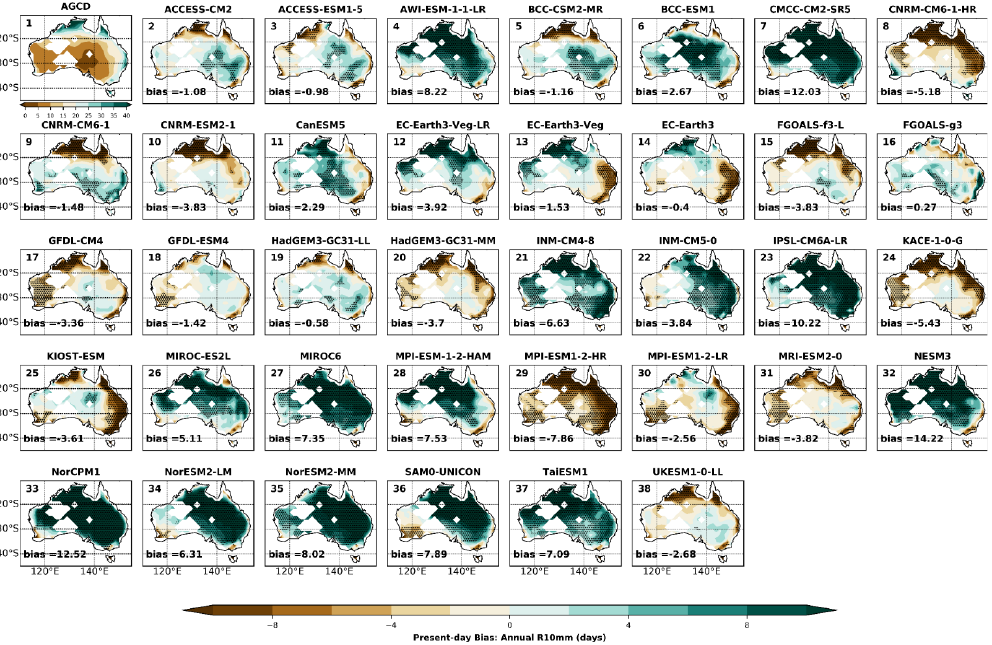
Figure 3. Climatological mean annual bias in the number of very heavy rain days (rain > 10 mm) (R10mm: days) relative to the Australian Gridded Climate Data dataset (AGCD; panel 1 ) for the individual CMIP6 GCMs (panels 2 – 38 ). Data spans 1951–2014. Stippling indicates statistically sig- nificant differences using a student’s t-test at the 95% confidence level. The white masks in part of the inland domain are the regions with no station data.